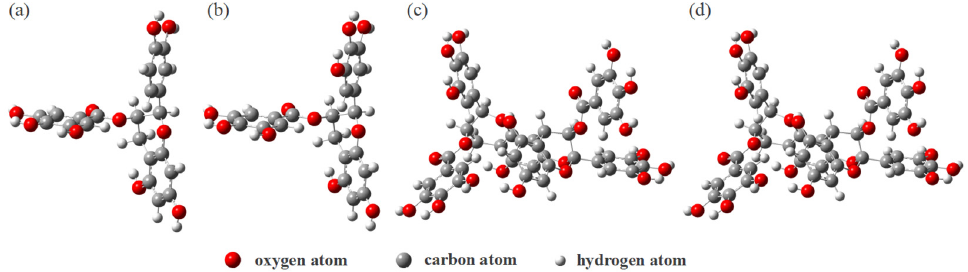
Figure 2. The optimized geometric models of the four characteristic structural units from PT: ( a ) ECG, ( b ) EGCG, ( c ) A − ECG dimer, ( d ) A − EGCG dimer. ( b ) EGCG, ( c ) A − ECG dimer, ( d ) A − EGCG